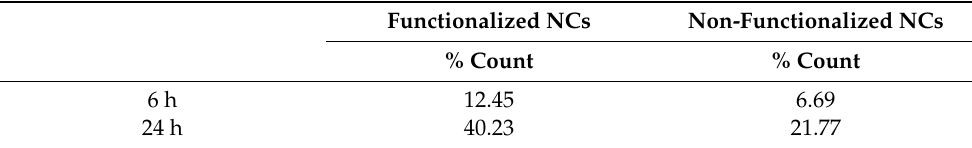
Table 2. FACS analysis. Percentage of HeLa cells emitting fluorescence at the different time